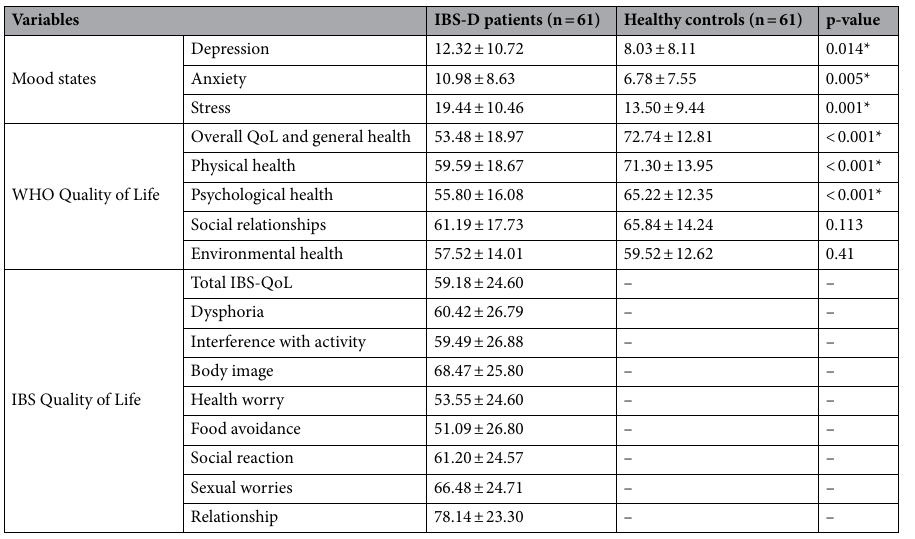
Table 2. Mood states and quality of life score of the participants. Data are presented as mean (standard deviation). Independent sample t-test was used for comparison of quantitative variables. *p-value < 0.05.